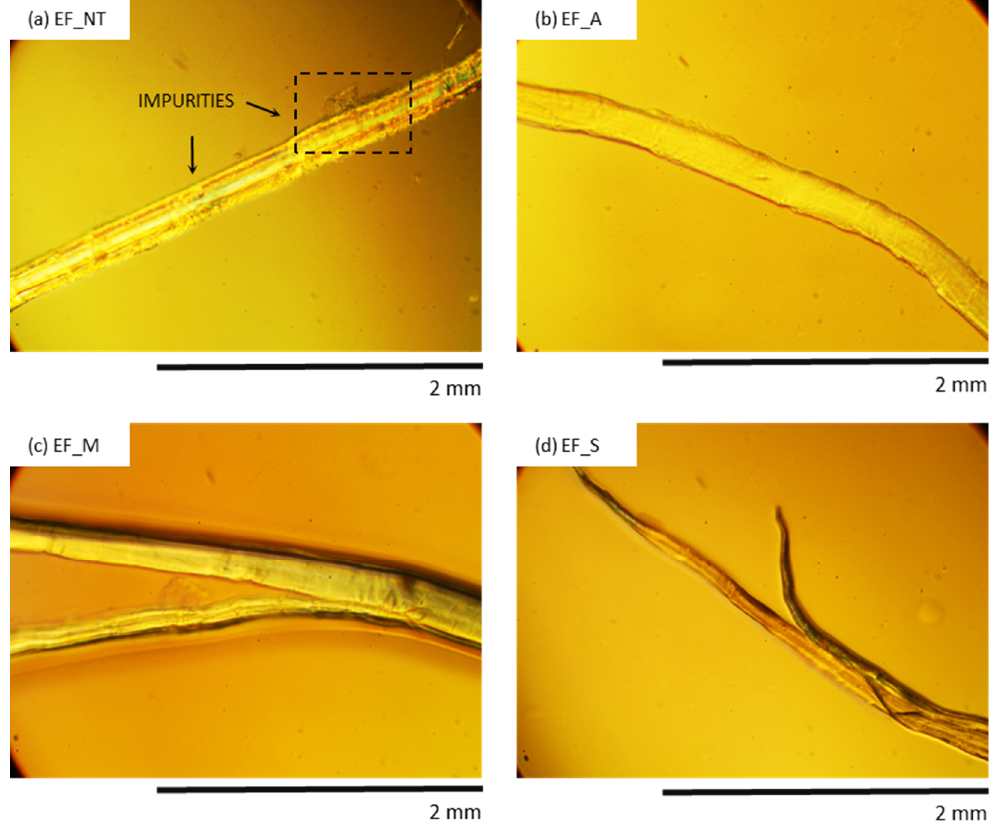
Figure 7. Optical image of ( a ) EF_NT, ( b ) EF_A, ( c ) EF_M and ( d ) EF_S observed at a magnification of 200.